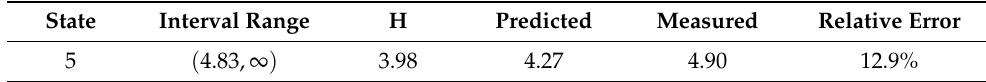
Table 8. Quantitative prediction of the sea clutter power of the latter